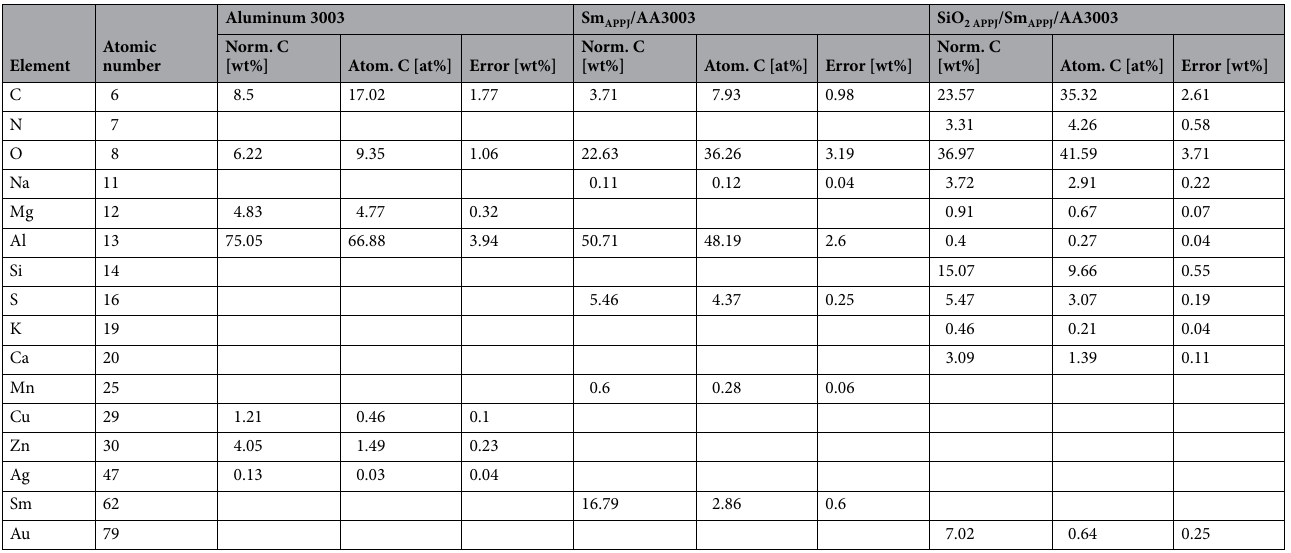
Table 1. EDS analyzes of aluminum (substrate), Sm APPJ coating on AA3003 (single layer), and SiO 2APPJ coating on a Sm APPJ coating on the AA3003 (double